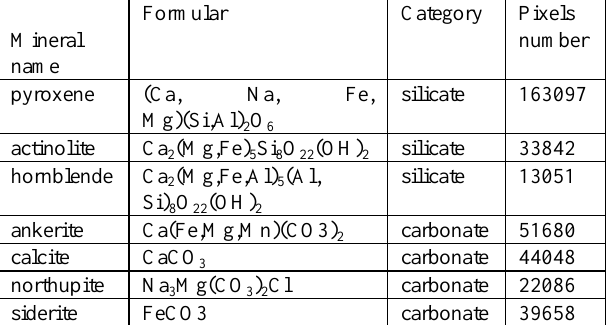
Table 1. Minerals detected by spectral angle